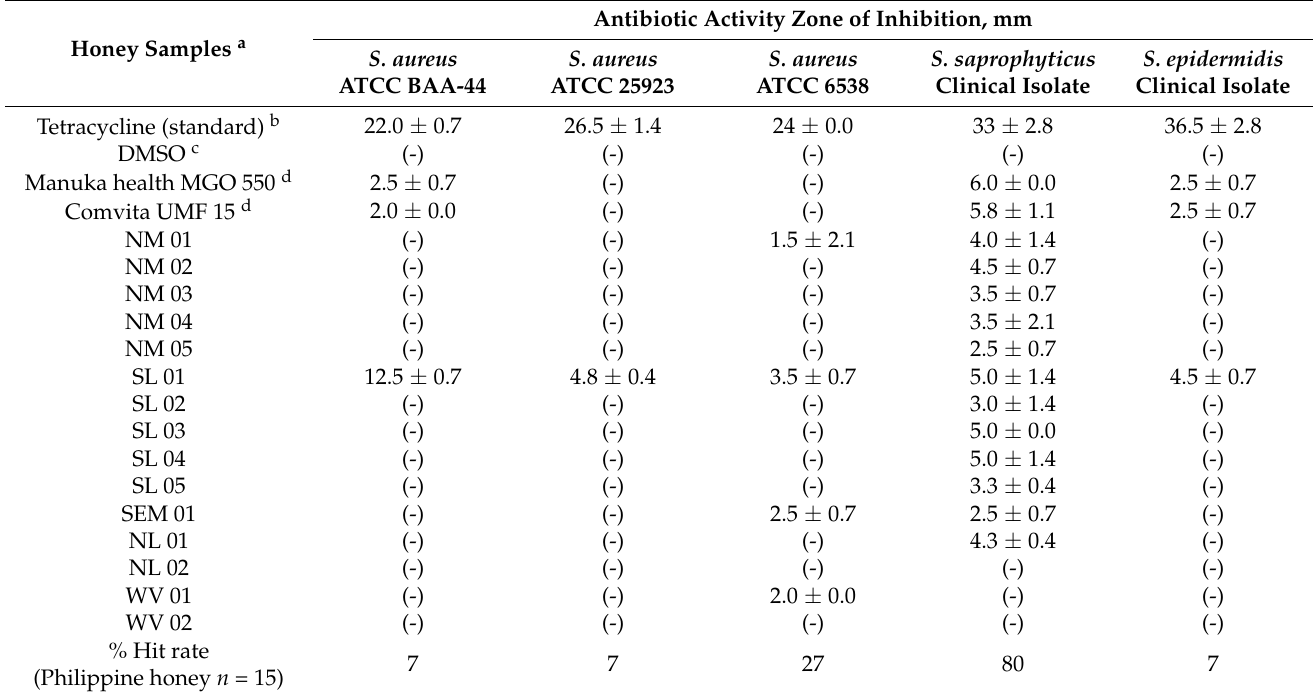
Table 2. Antibacterial Activity of Honey Extracts Against Staphylococcal Pathogens.